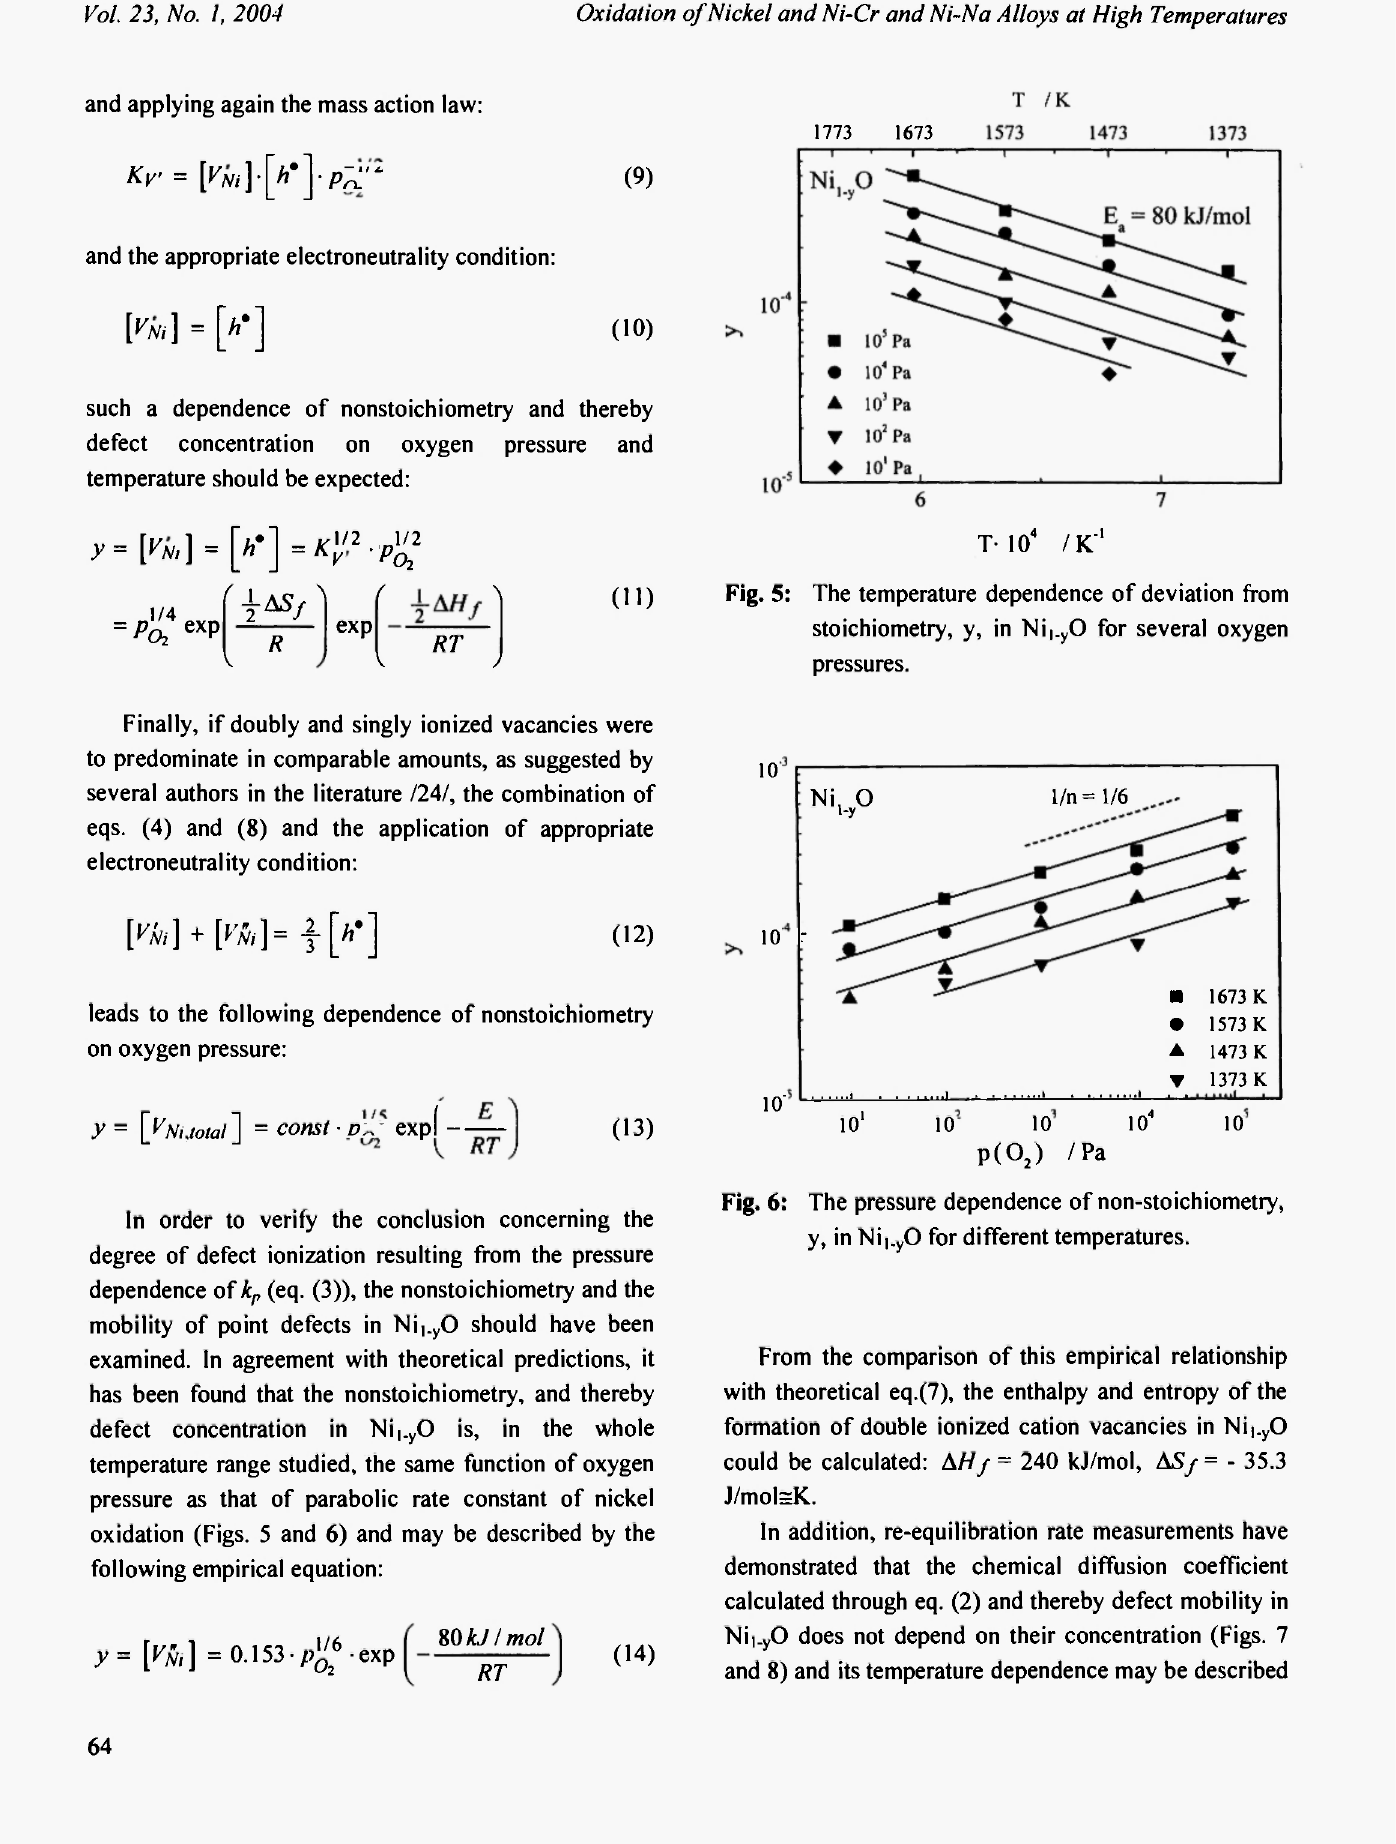
Fig. 6: The pressure dependence of non-stoichiometry, y, in Ni,. y O for different temperatures.